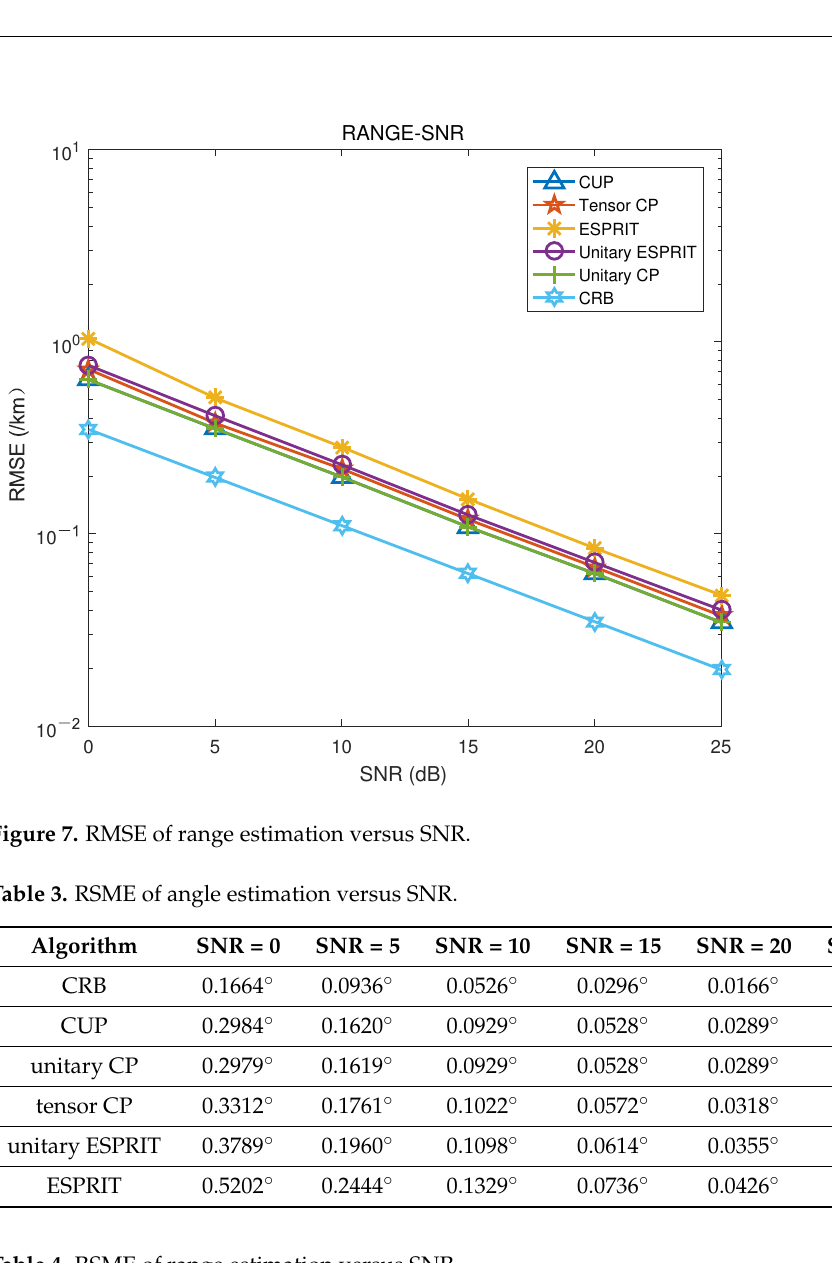
Table 4. RSME of range estimation versus